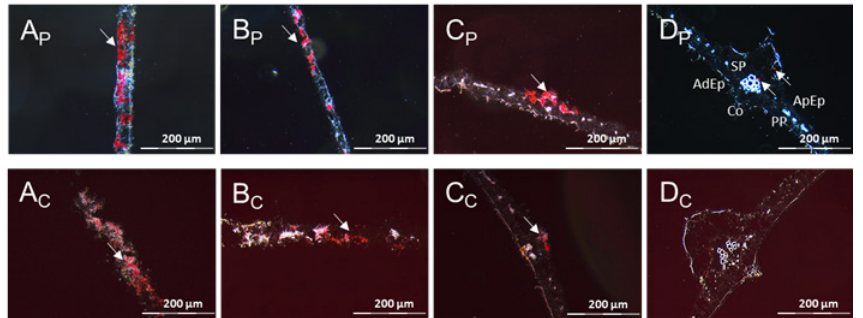
Figure 12. Distribution of UCBSV-Ke125 RNA in cross sections of DSC 167 cassava leaf tissues. Cross sections from cassava subjected to RNAscope ® ISH using an UCBSV-Ken125 probe. Red signal indicates the presence of the viral RNA in phloem cells and non-phloem cells (white arrows). ( Ap – Dp ) Sections prepared from samples embedded in paraffin. ( Ac – Dc ) Tissues subjected to cryo- sectioning. X, xylem; PP, palisade parenchyma; SP, spongy parenchyma; AdEp, adaxial epidermis; AbEp, abaxial epidermis; AbPh, abaxial phloem; AdPh, adaxial phloem; Co, collenchyma cells.